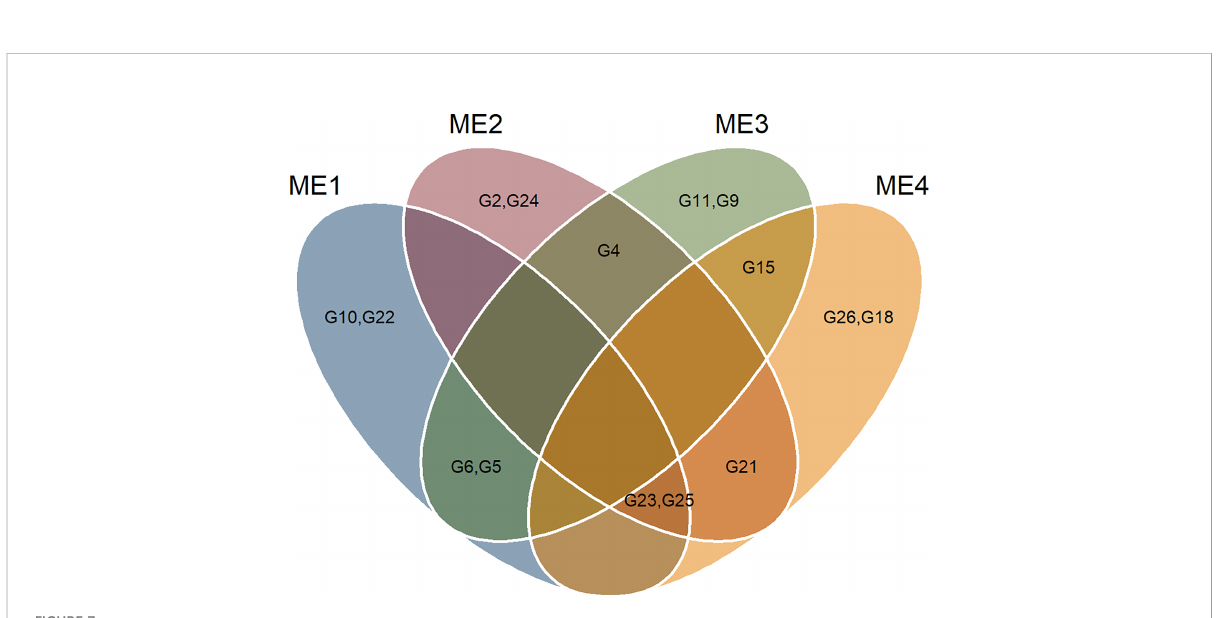
FIGURE 7 Veen plot showing the selected genotypes in each